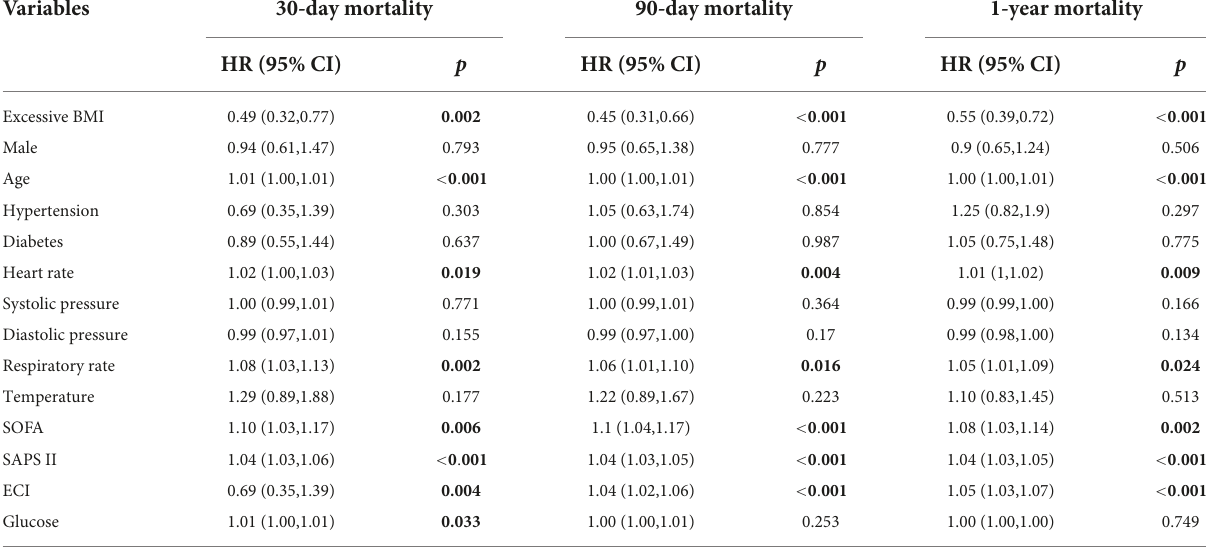
TABLE 3 Dominant mortality factors by univariable analysis.